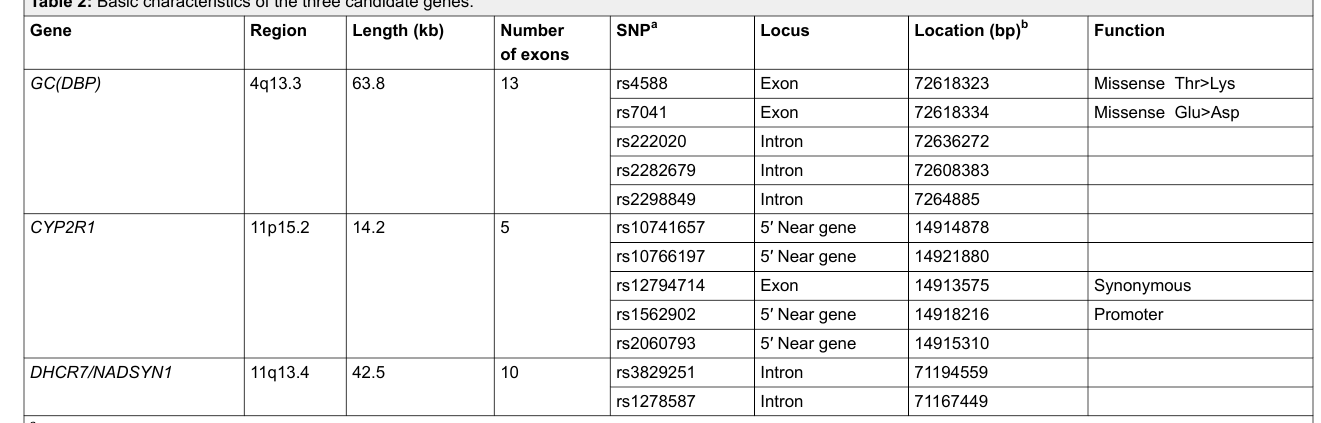
Table 2: Basic characteristics of the three candidate genes.